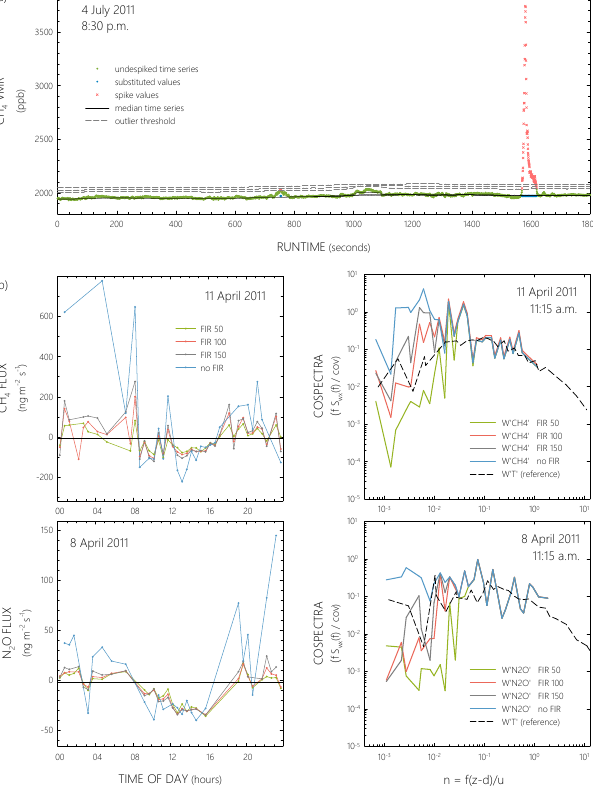
Figure 1. (a) Despiking example of 2Hz methane volume mixing ratios (VMRs) using median filters. (b) Diurnal courses (left pan- els) and normalized co-spectra (right panels) illustrating the effect of high-pass filtering CH 4 (upper panels) and N 2 O (lower panels) time series with a non-recursive finite impulse response (FIR) fil- ter with different time constants (50, 100 and 150s). Sensible heat co-spectra are shown in the right panels for